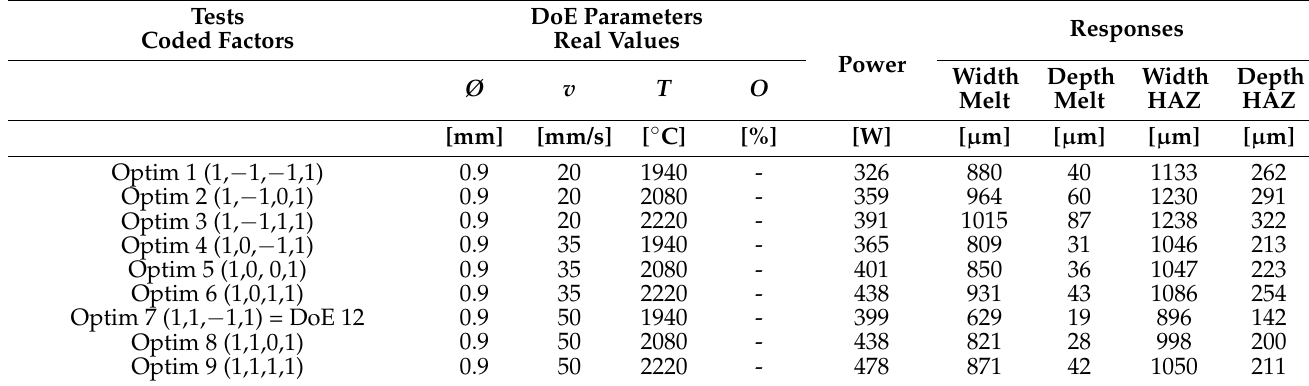
Table 7. Measurements of the re-melted layer and HAZ for the optimization tests.